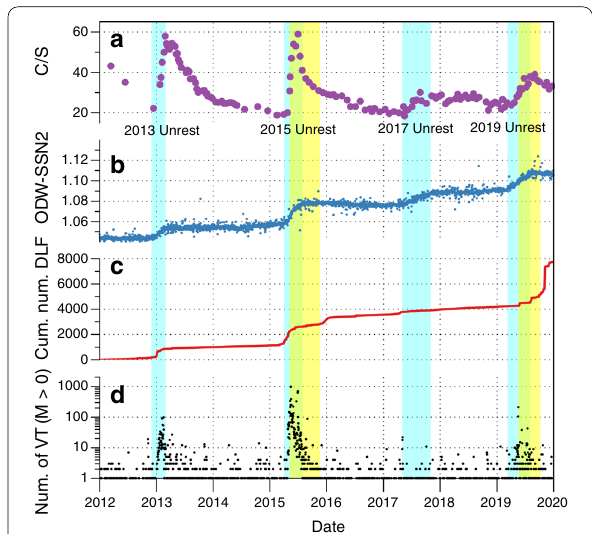
Fig. 3 Sequential change of a) CO 2 /H 2 S (C/S) molar ratio of fumarole gas emitted from a fumarole in Owakudani (Daita et al, 2019; Ohba et al, 2019), b) baseline length across Hakone volcano (Odawara – Susono2 20,747 m), c) cumulative number of deep low frequency + events, and d) daily number of volcano-tectonic earthquakes in Hakone volcano. Durations of VAL 2 or more are shown as